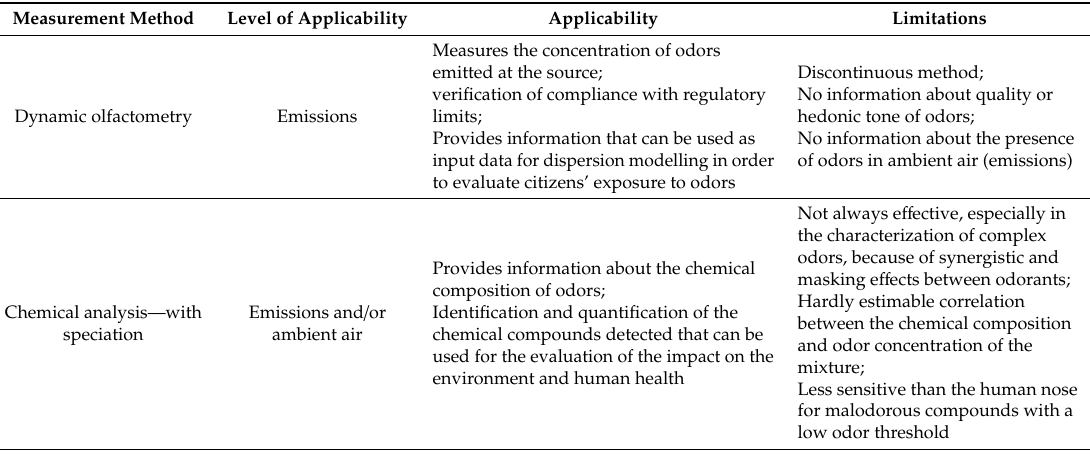
Table 1. Schematization of the di ff erent measurement methods in terms of their applicability and